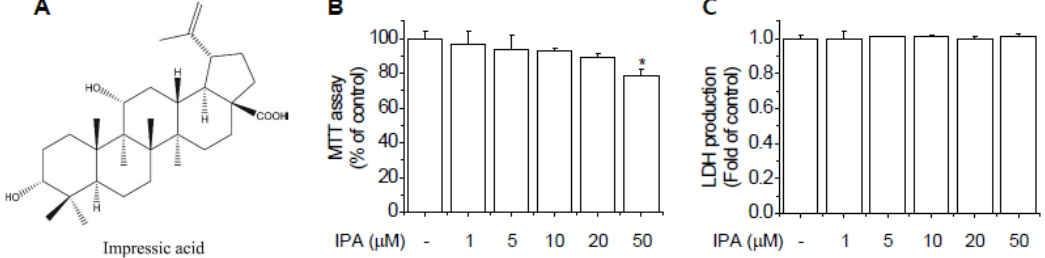
Figure 1. The e ff ects of impressic acid (IPA) on the cytotoxicity of EA.hy926 cells. ( A ) Chemical structure of IPA. ( B , C ) EA.hy926 cells were treated with 1, 5, 10, 20, and 50 µ M IPA for 24 h. Cytotoxicity was assessed by 3-(4,5-dimethylthiazol-2-yl)-2,5-diphenyltetrazolium bromide (MTT) ( B ) and LDH ( C ) assays. Data are means ± SD of three independent experiments. * p < 0.05 compared with